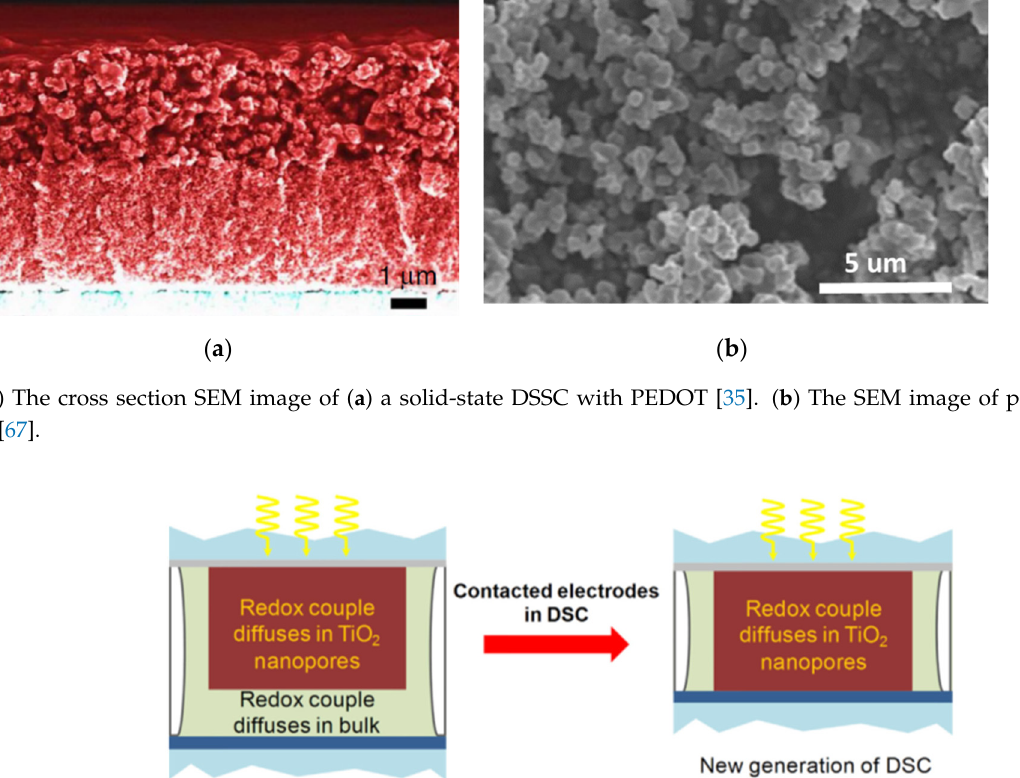
Figure 5. The molecular structures of the conductive polymer of ( a ) PEDOT [35], ( b ) cPEDOT [66], and ( c ) Polypyrrole [67].